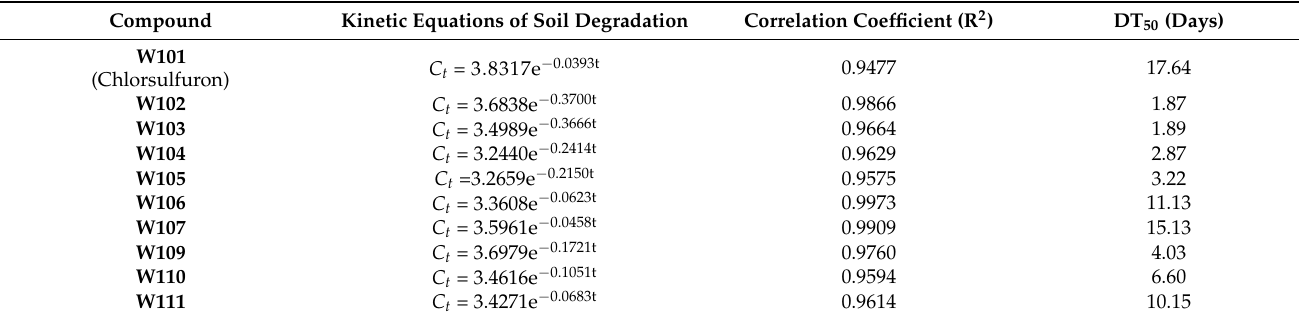
Table 3. Kinetic parameters for acidic soil (pH 5.46)